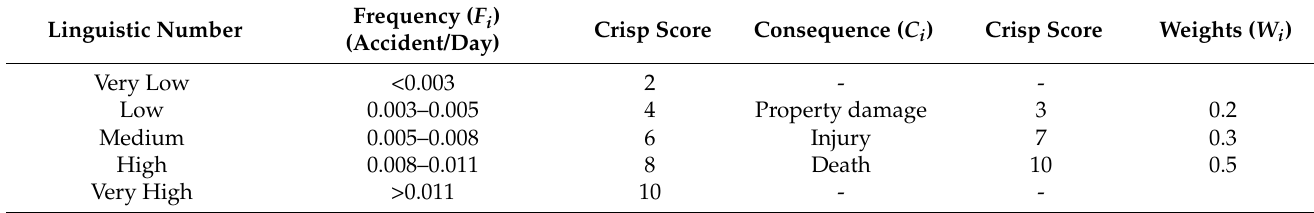
Table 3. Domain of discourse for accident risk